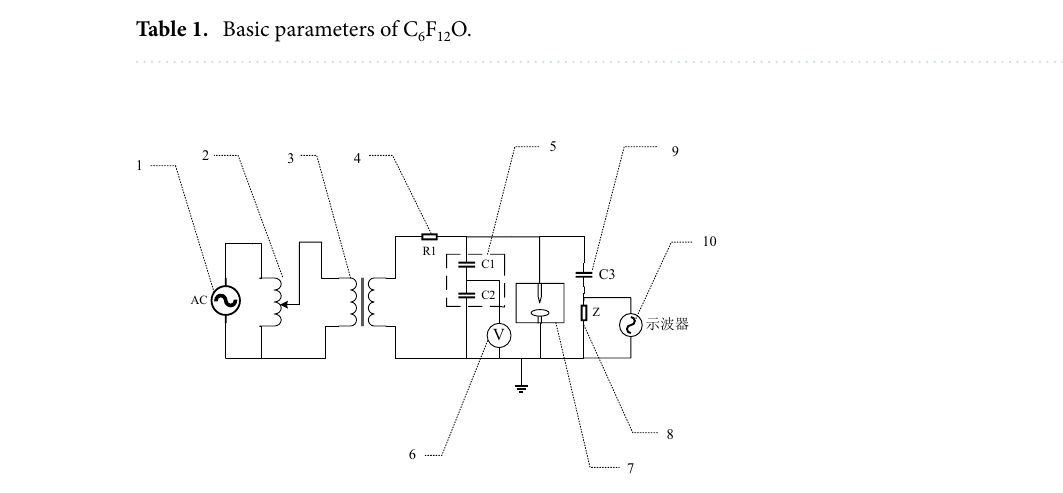
Figure 2. Experimental circuit diagram. 1—AC power supply 2—AC voltage regulator 3—No halo test transformer 4—Protection resistance 5—Capacitor divider 6—Voltage meter 7—Discharge chamber 8—No sense detection impedance 9—Coupling capacitor